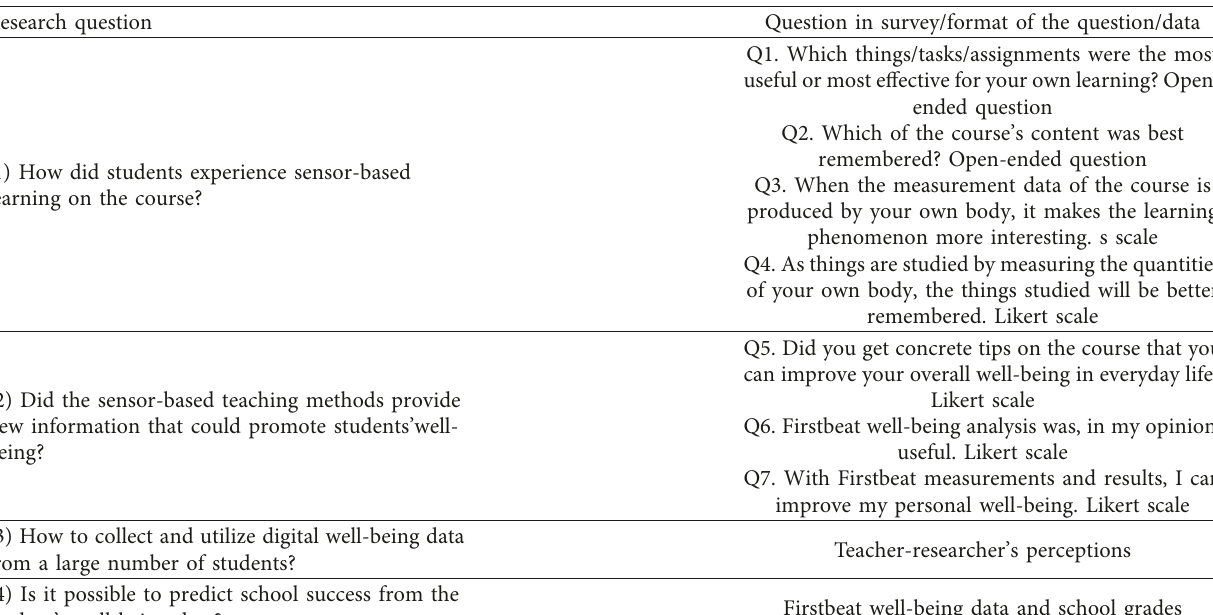
Table 2: Main research questions and related questions in